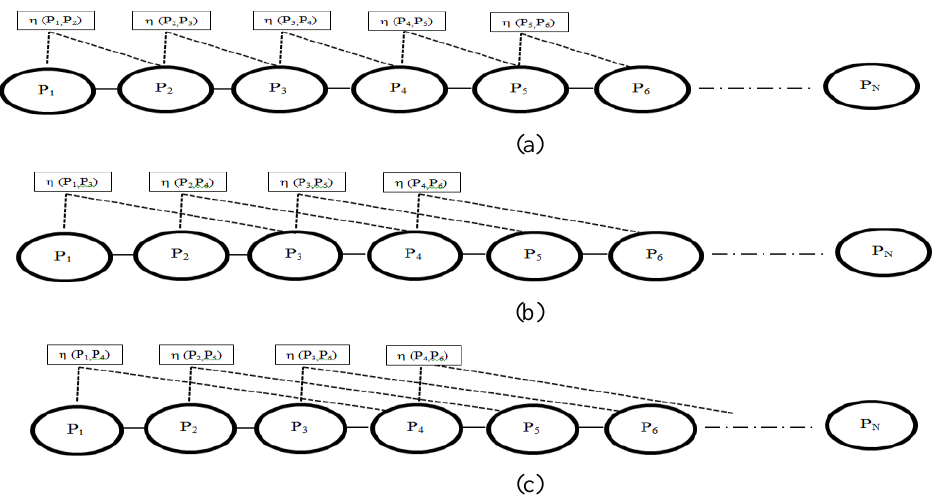
Figure 1: (a) the first-tier, (b) the second-tier, and (c) third-tier sequence order correlation mode along a protein